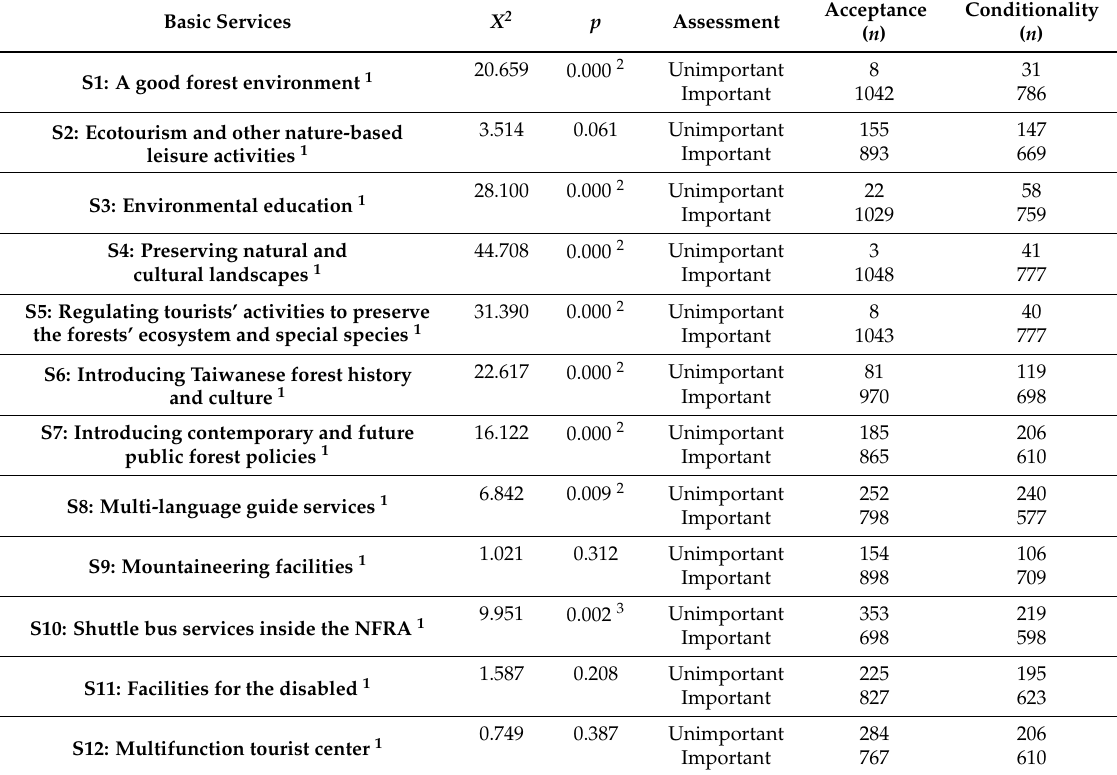
Table 4. Perceptions of the importance of basic services by